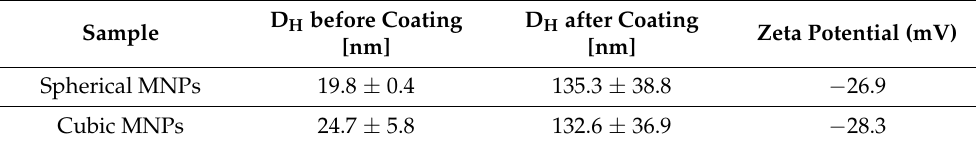
Table 3. DLS measurements of the PEG-coated MNPs.